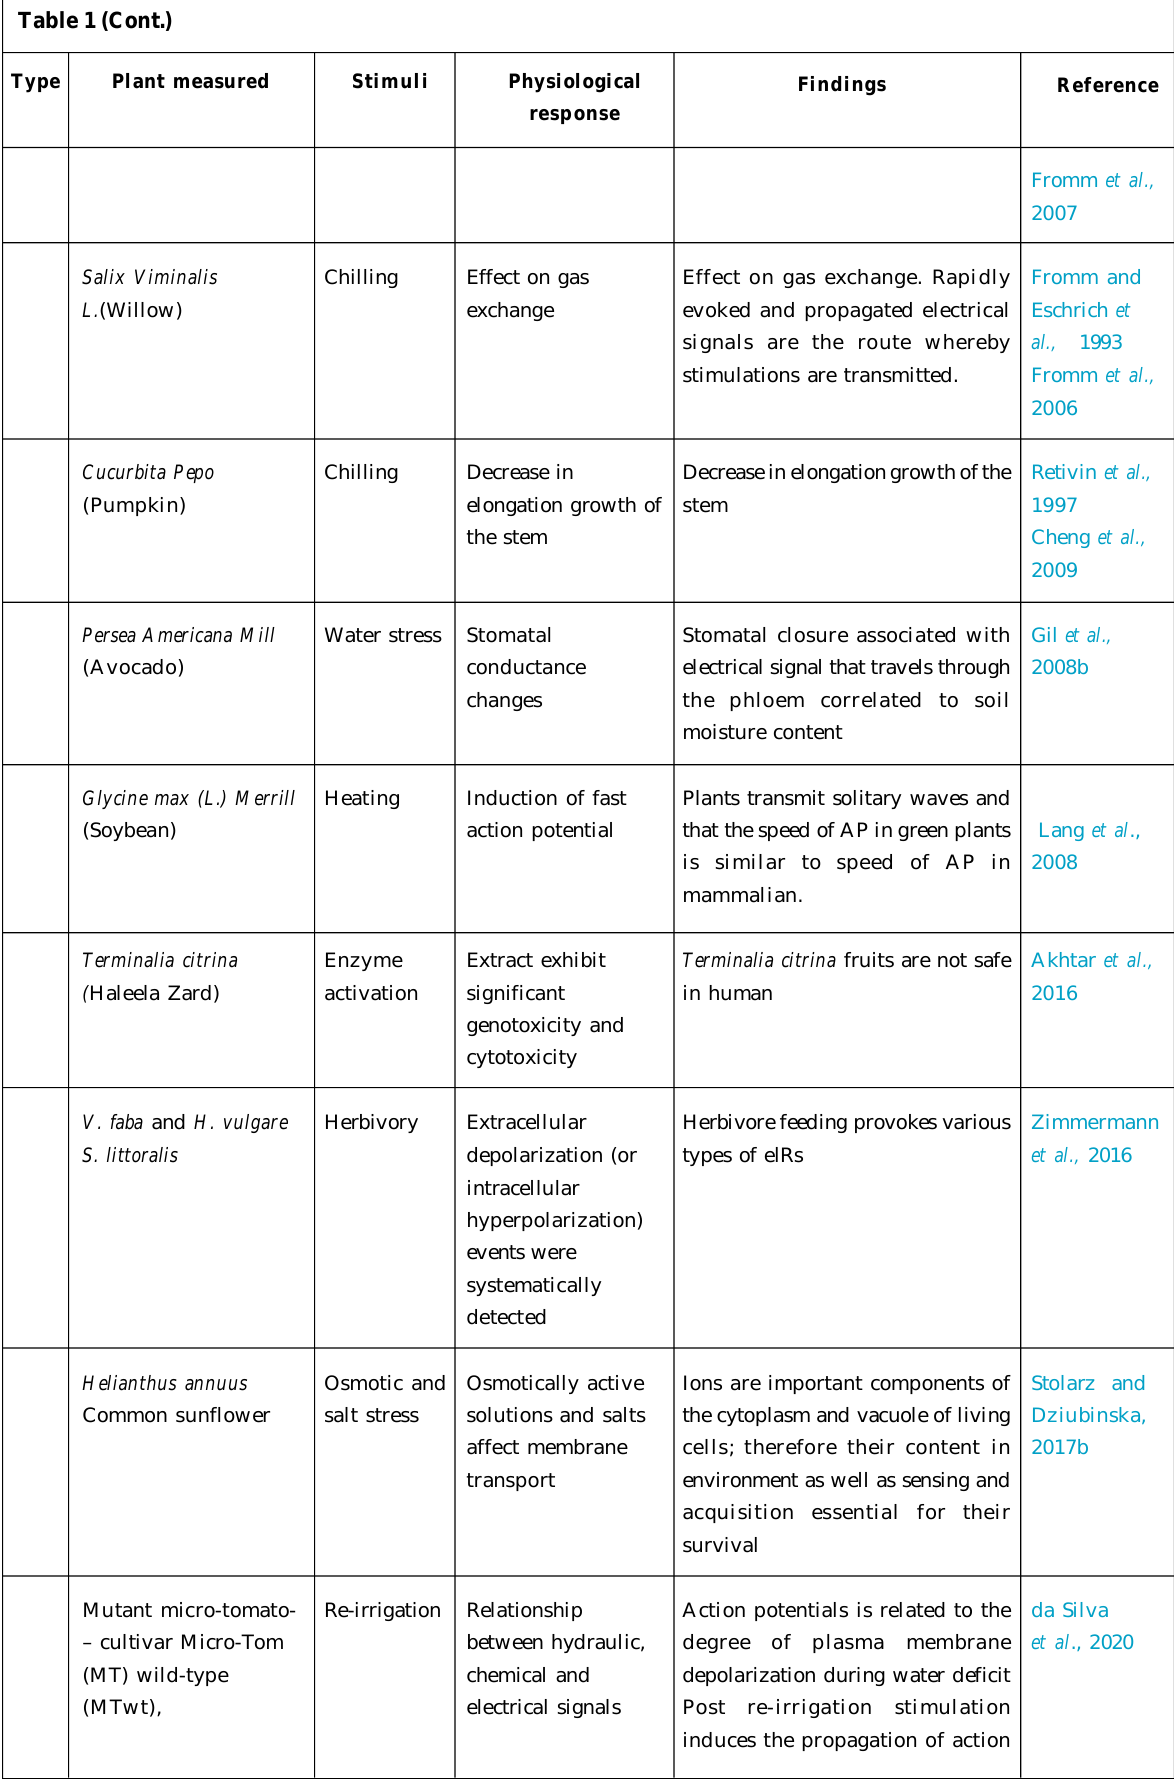
Findings ReferenceType response